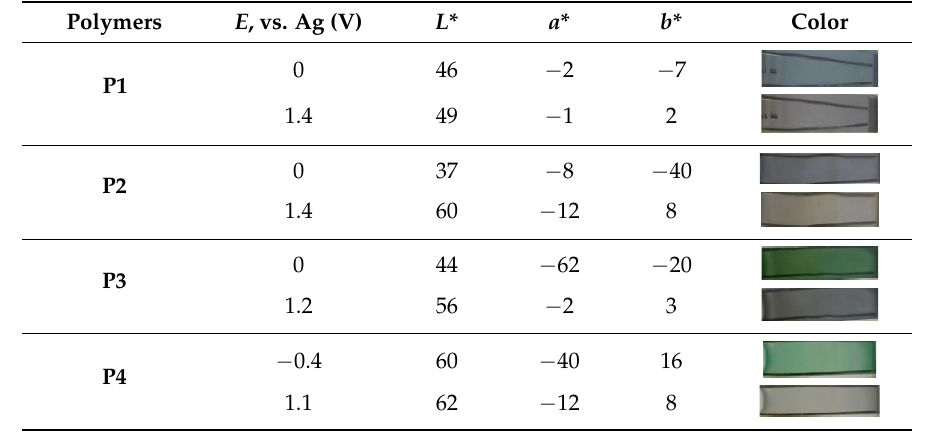
Table 3. The colorimetry analyses of the polymers. Polymers